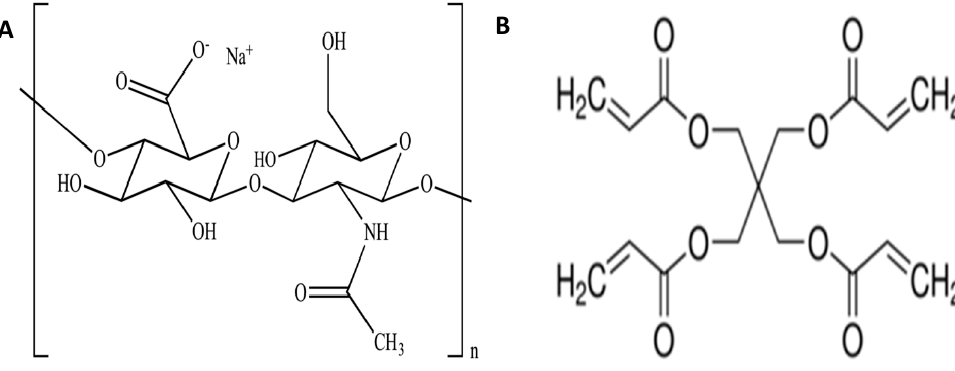
Figure 1. Chemical structures of: A ) sodium Hyaluronate and B ) pentaerythritol tetra-acrylate.